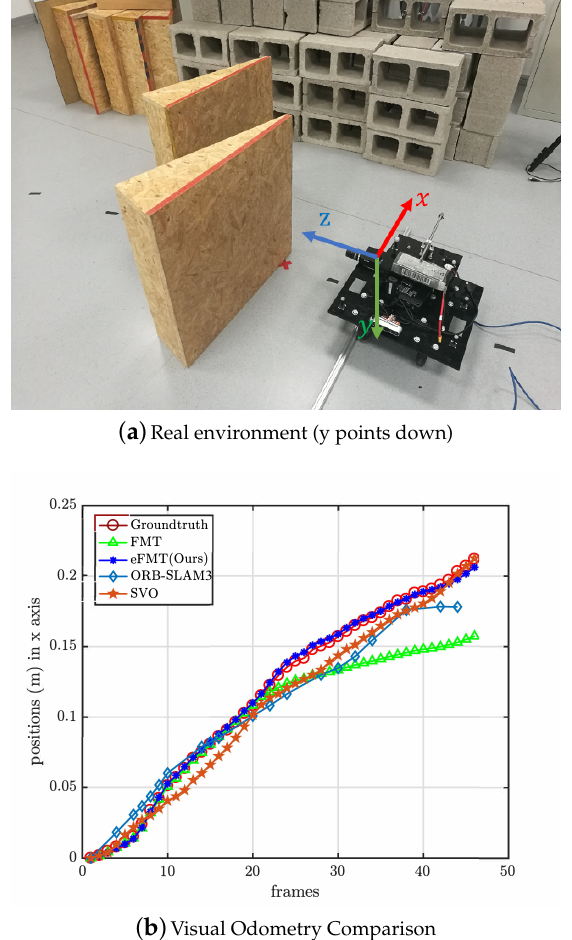
Figure 11. A visual odometry example in a real-world environment. DSO fails in this test, thus it is ignored in this